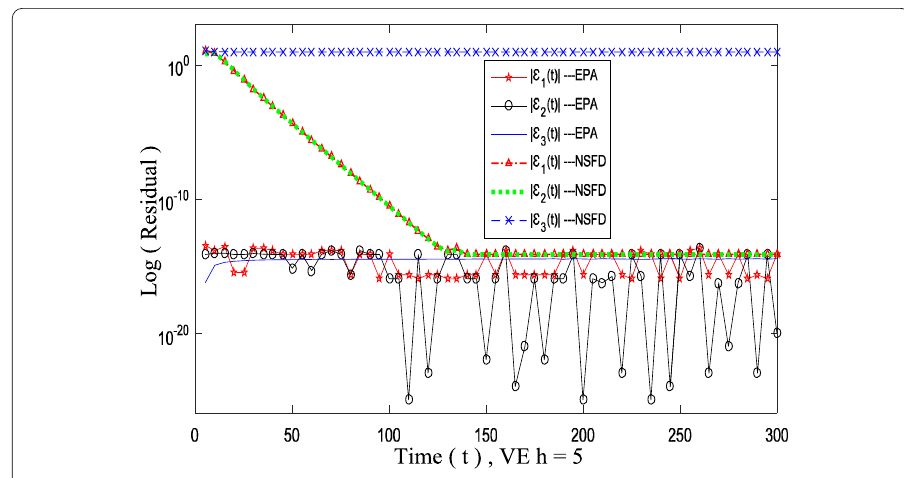
Figure 11 Absolute residuals of EPA and NSFD solutions at VE for h = 5